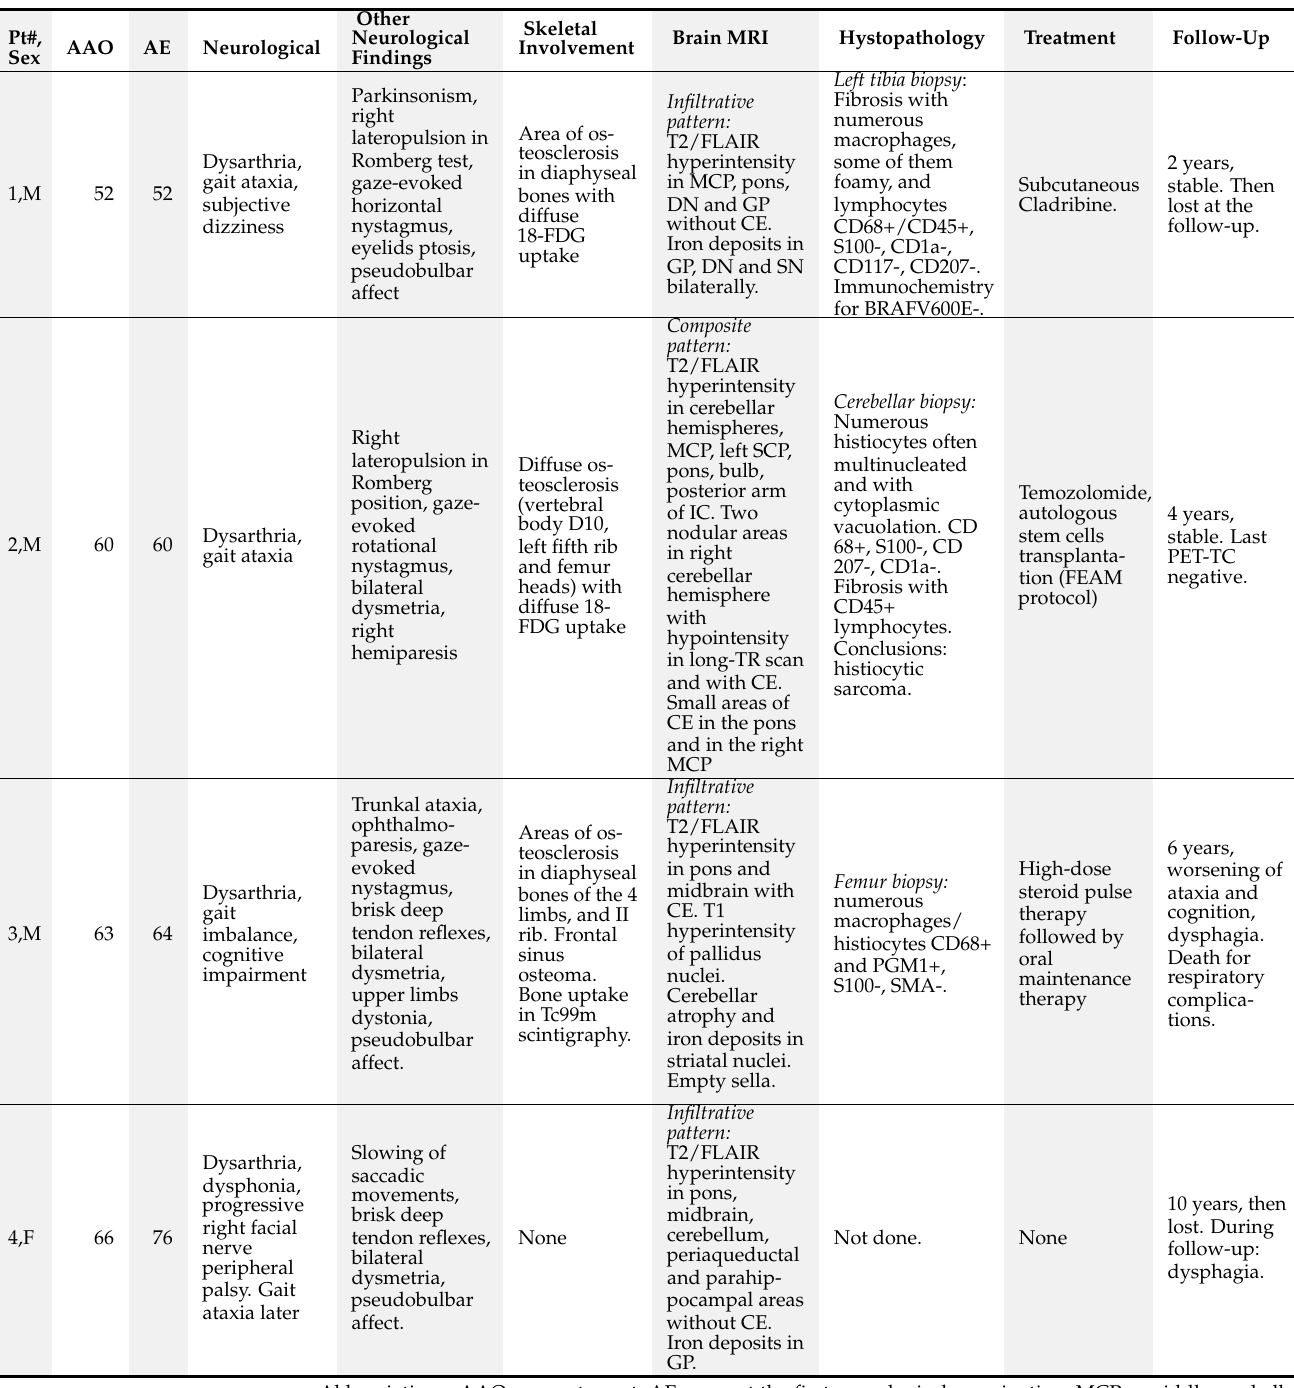
Table 1. Summary of the demographic, main clinical, and diagnostic features documented in our case series and related treatment